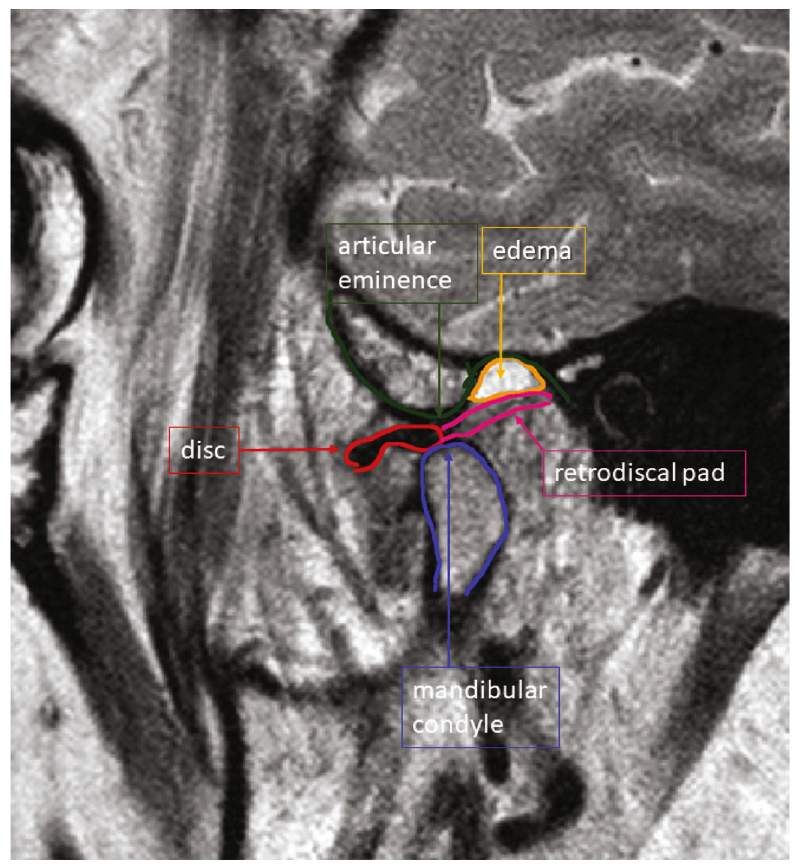
Figure 3: Initial MRI of the left TMJ with the patient ’ s mouth open revealed anterior disk displacement of the left articular disk with signi fi cant anatomical deformity (thickening of the posterior edge) and e ff usion in the left TMJ. The dynamic sequences revealed limited condyle movement, disk deformity, and displacement without reduction on opening. Joint e ff usion was